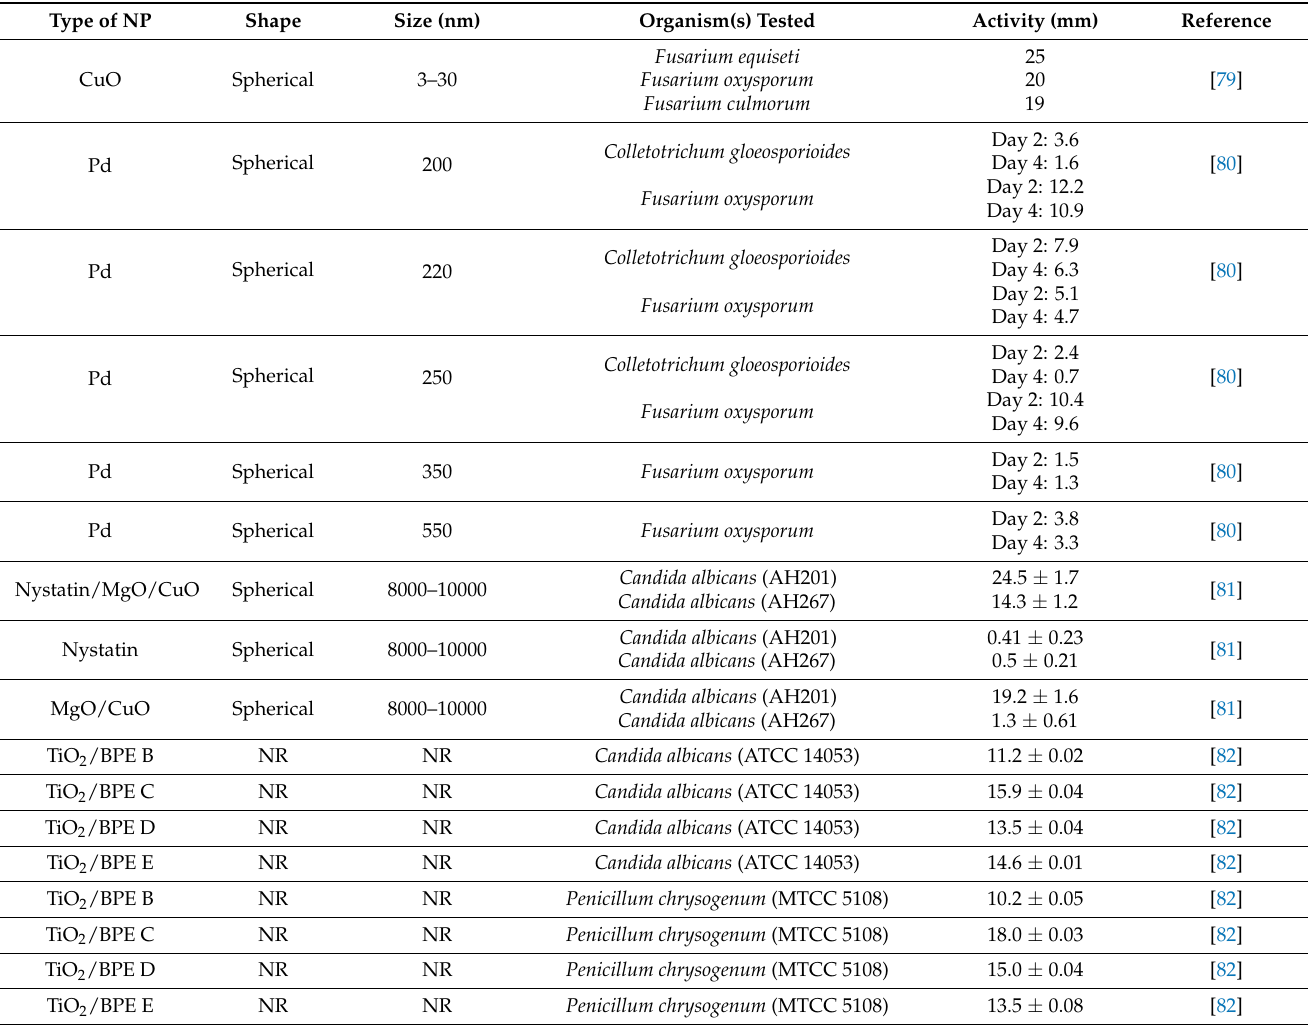
Table 5. Activities of NPs tested on different fungal species expressed as the zone of inhibition (mm).